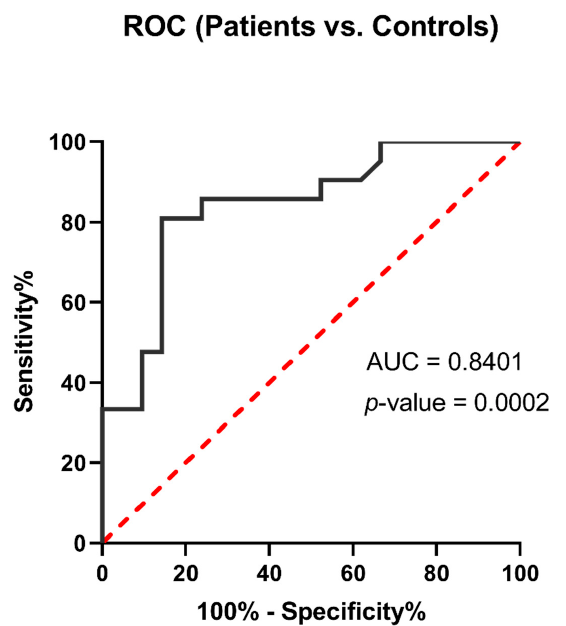
Figure 4. ROC analysis of COVID-19 samples compared to healthy individuals. The analysis showed a significant diagnostic value for Arg1 gene expression. 3.6. Arg1 Might Have Interacted with Other Enzymes in the Blood The PPI network analysis of Arg1 showed that the Arg1 could remarkably interact with ornithine aminotransferase (OAT), nitric oxide synthase 2 (NOS2), and ornithine carbamoyltransferase (OCT) with scores of 0.995, 0.978, and 0.976, respectively (Figure 5). The results confirmed other possible enzymatic changes during the COVID-19 and the involvement of other catalysis enzymes that have considerable associations with Arg1.